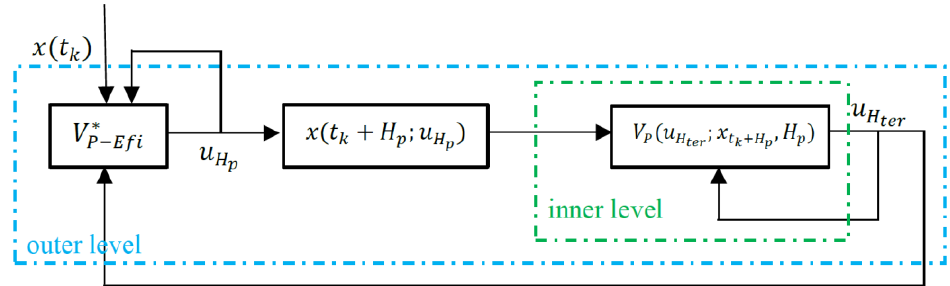
Figure 4. Illustration of the nested structure in practical EfiMPC.